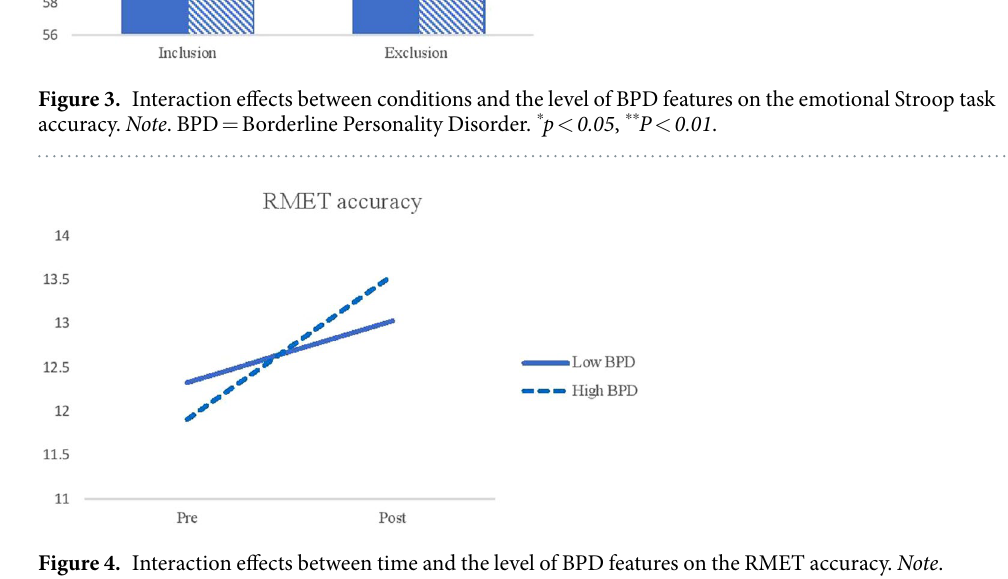
Figure 4. Interaction effects between time and the level of BPD features on the RMET accuracy. Note . BPD = Borderline Personality Disorder. RMET = Reading the Mind in the Eyes Test.